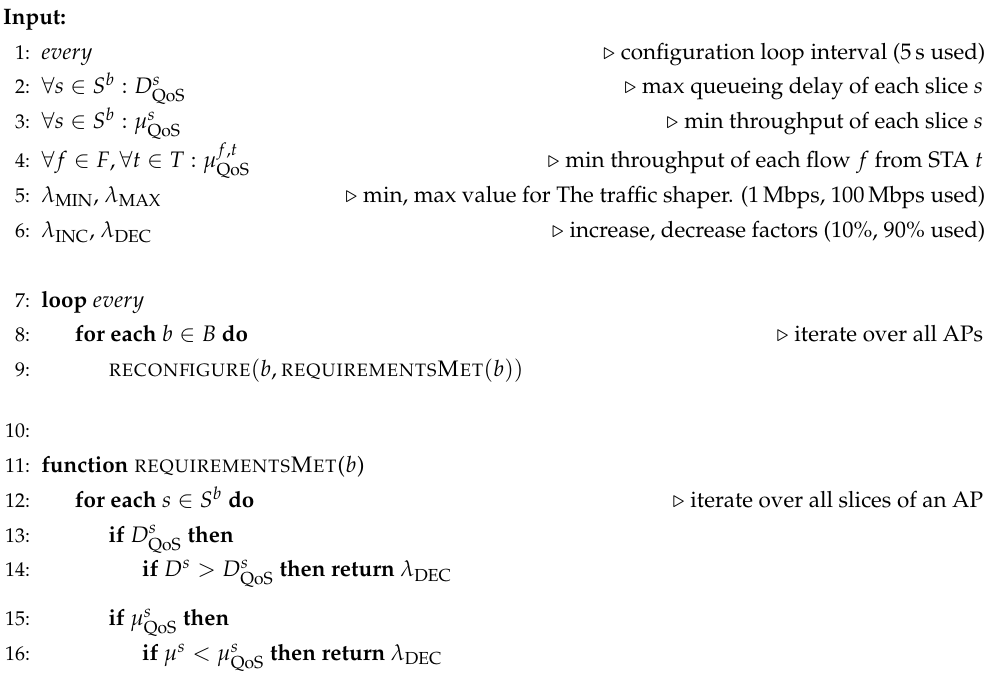
Algorithm 3 Traffic Shaping